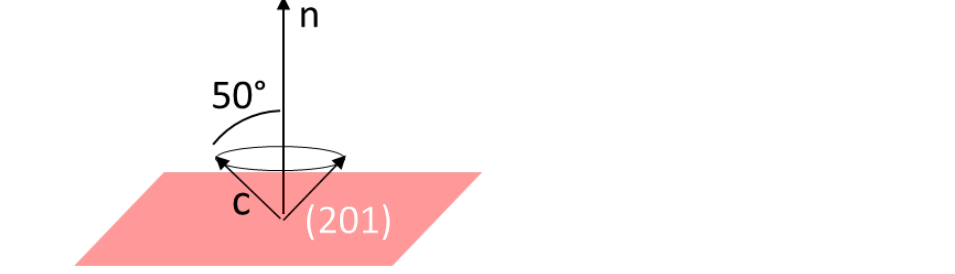
Figure 18. Schematic representation of possible directions of the c-axis with respect to the (201) plans of STS.